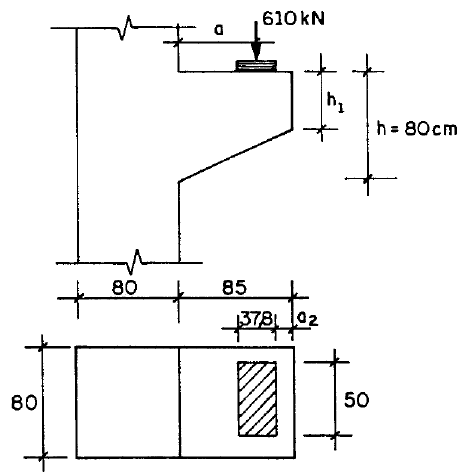
Figure 12. Trapezoidal corbel (dimensions in cm)